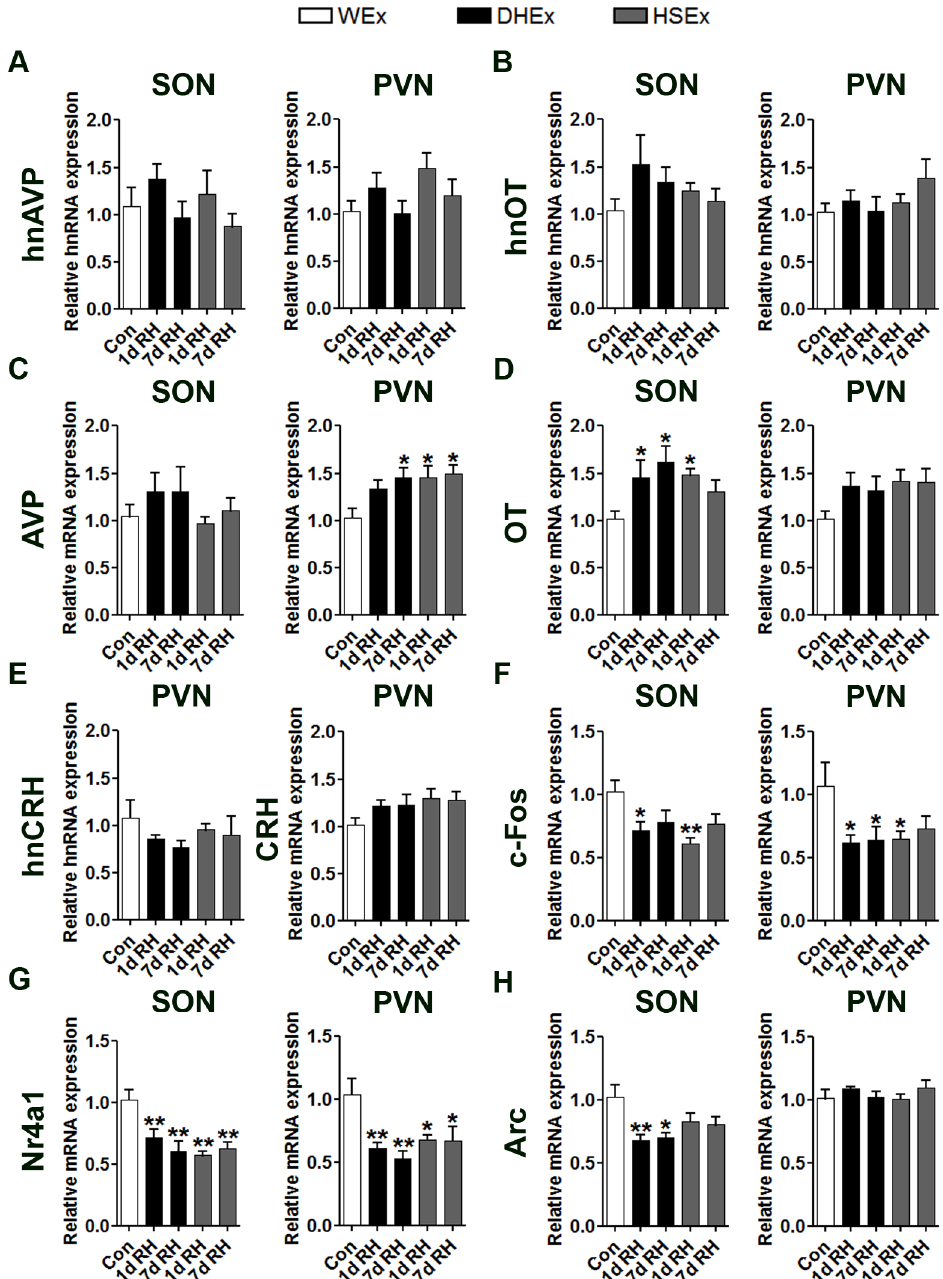
Figure 6. Gene expression changes in rat SON and PVN 1 d and 7 d after DHEx or HSEx compared to control animals. Relative mRNA expression of hnAVP, hnOT, AVP, OT, hnCRH, CRH, c-Fos, Nr4a1 and Arc was investigated by qPCR in the SON and PVN of rats RH (1 d and 7 d) after DHEx and HSEx. Values are means + SEM of n=6 animals per group. *p , 0.05, **p , 0.01, ***p , 0.001. DH, dehydrated; DHEx dehydrated exposed; HS, hypertonic saline; HSEx, hypertonic saline exposed; RH, Rehydration.